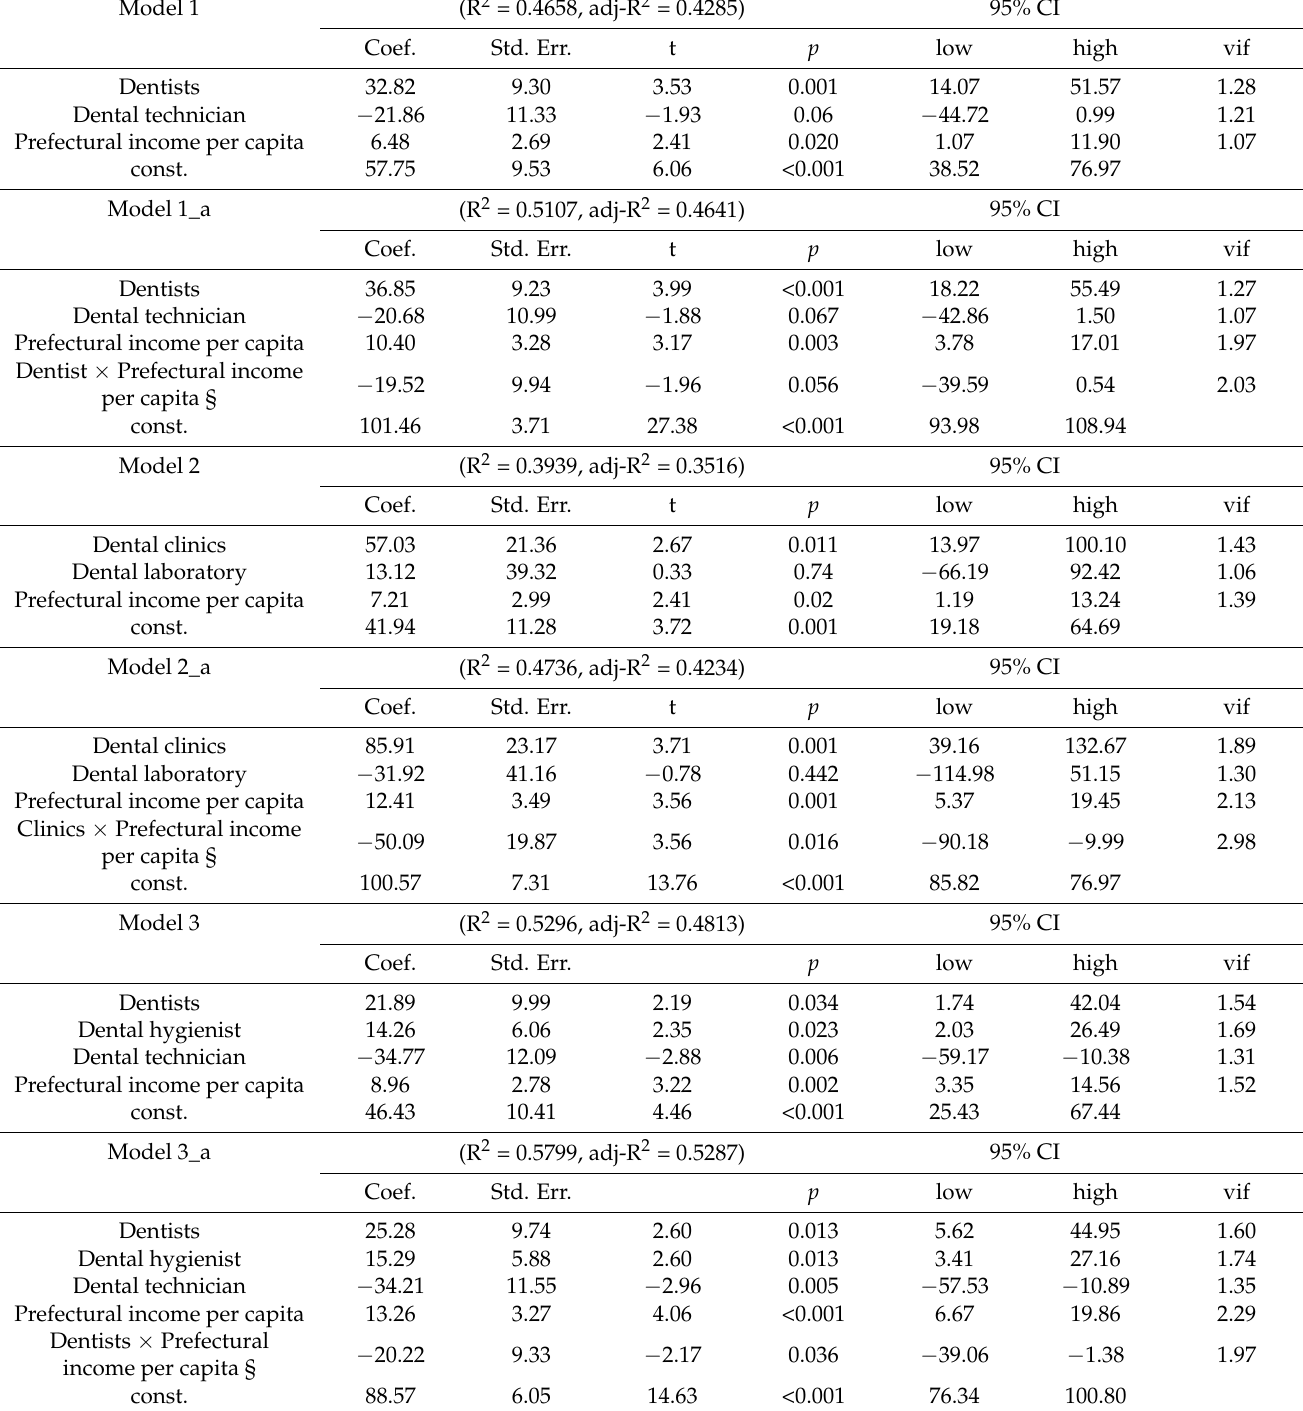
Table 3. Multiple linear regression models as the SCR of total dental receipts an outcome variable in FY2018. Model